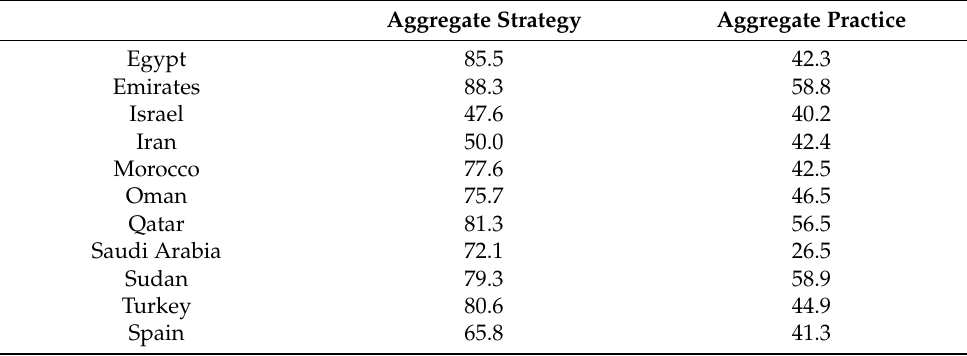
Table 4. Aggregate strategy and aggregate practice in MENA and Spain.